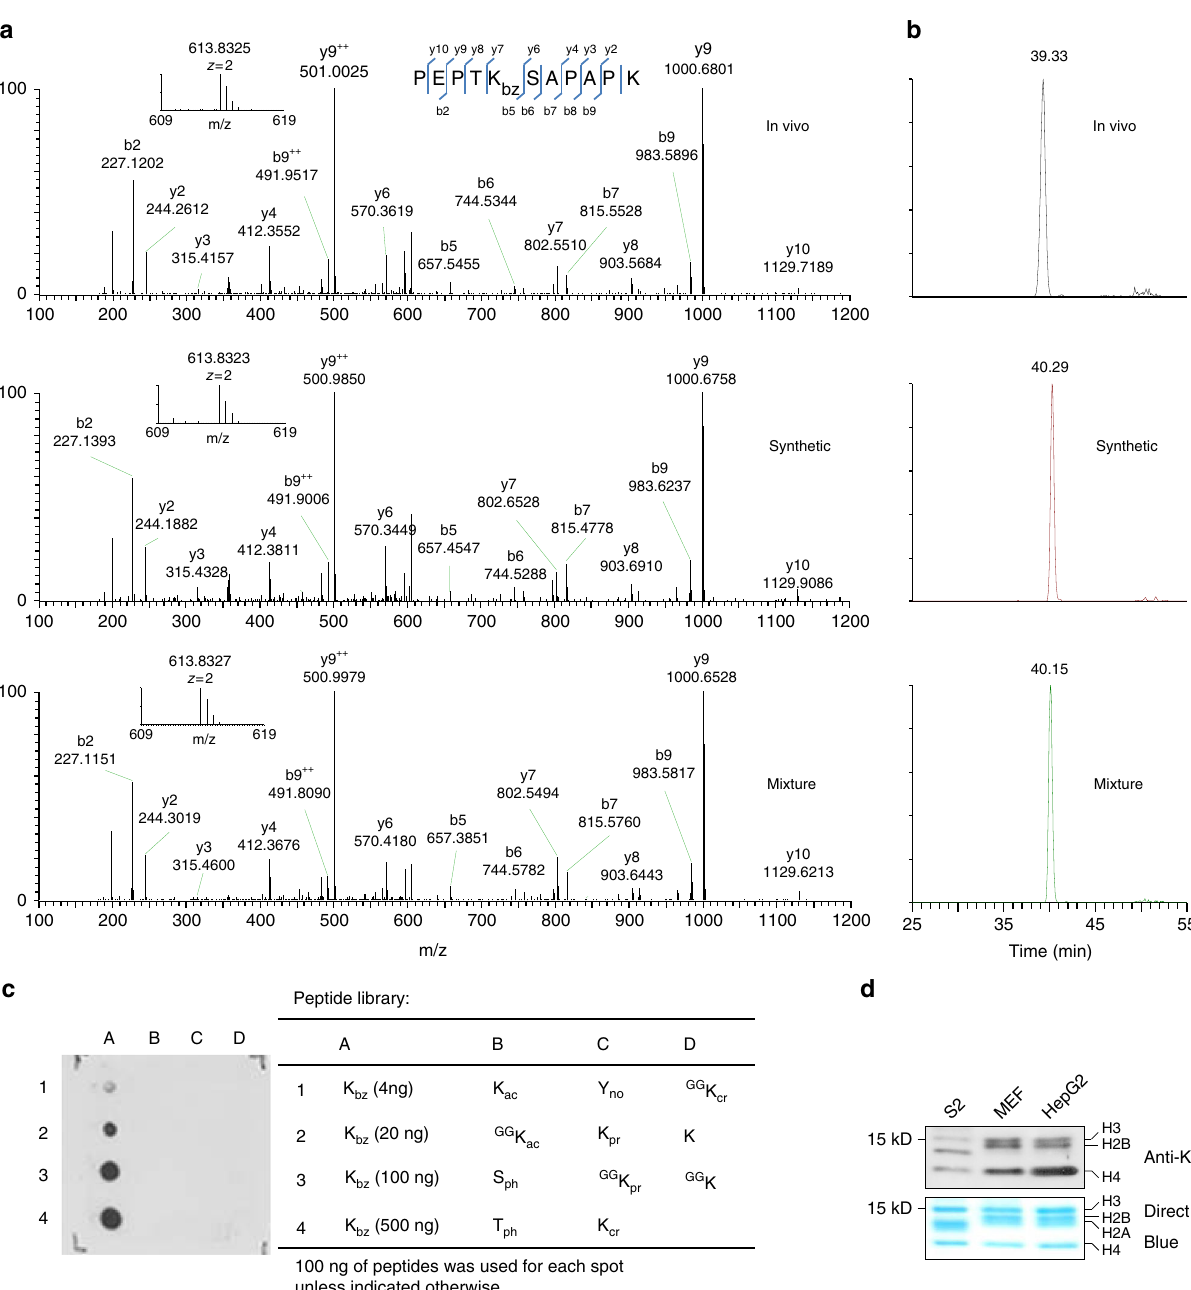
Fig. 2 Identi fi cation and veri fi cation of histone K bz . a The MS/MS spectra of an in vivo peptide bearing a PTM (PEPTK + 104.0268 SAPAPK) (top), a synthetic lysine benzoylated peptide corresponding to the sequence of the in vivo peptide (middle), and a mixture of the two peptides (bottom). b Extracted ion chromatograms of the in vivo-derived peptide (PEPTK + 104.0268 SAPAPK) (top), the synthetic K bz counterpart (middle), and their mixture (bottom) by HPLC-MS/MS analysis. c Dot blot assay of the pan anti-K bz antibody. Peptide libraries were used for the assay. Each peptide library contains 10 residues CXXXXKXXXX, where X is a mixture of 19 amino acids (excluding cysteine), C is cysteine, and the sixth residue is a modi fi ed lysine residue as indicated. d Detection of K bz in core histones from Drosophila S2 cells, MEF cells, and HepG2